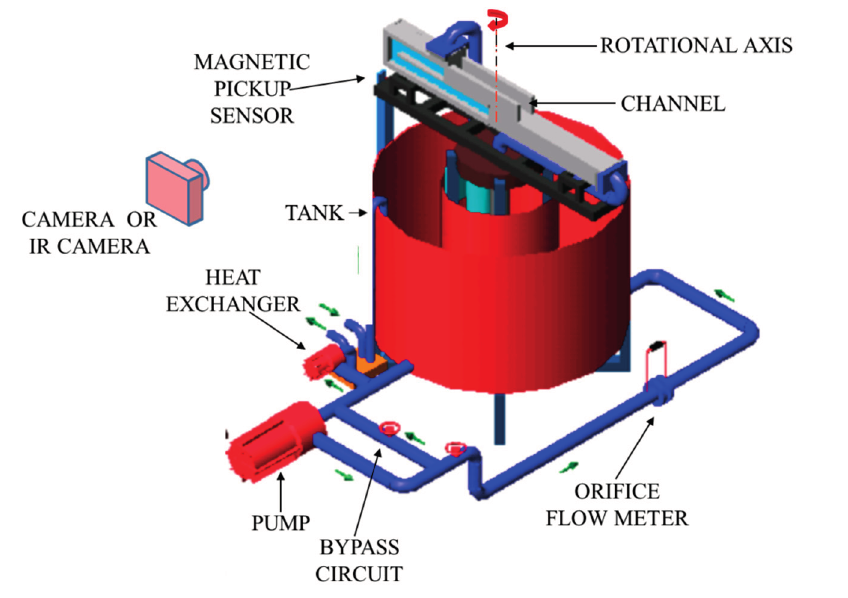
Figure 22. Experimental apparatus for a rotating channel of Gallo et al . [17].